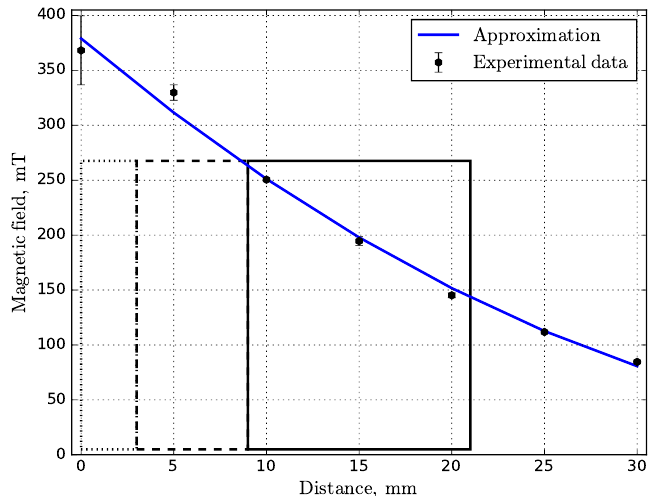
Figure 6. MF versus the distance from the top of the magnet surface. The corresponding rectangular regions are as follows: air gap (dotted), substrate (dashed), printed sample (solid). The average value of the vertical MF B 1 =